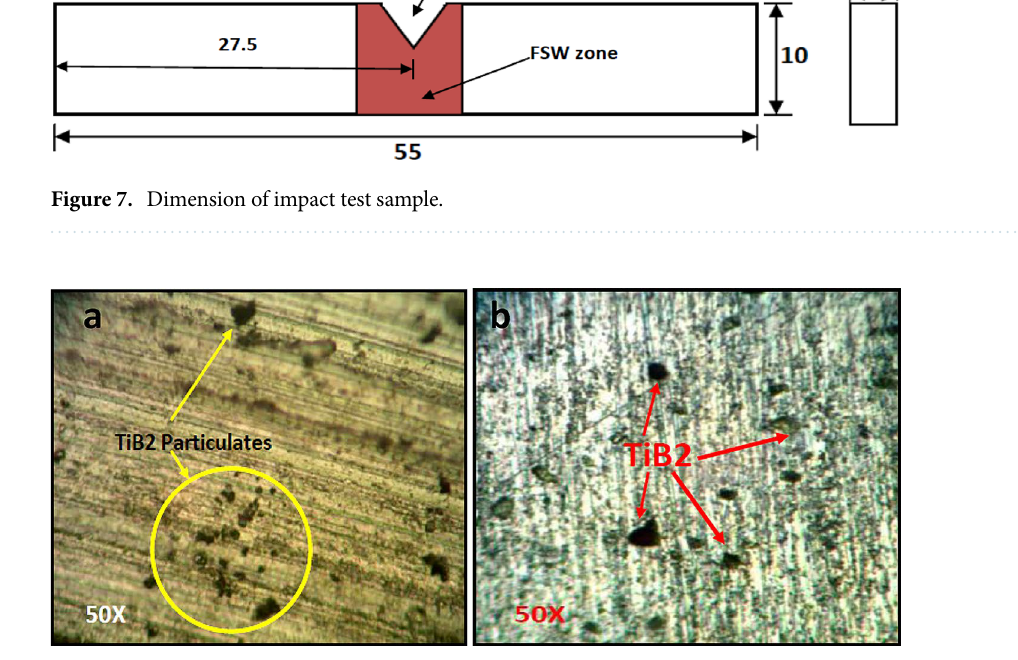
Figure 8. Optical micrograph of friction stir weld zone fabricated at ( a ) 2240 and ( b ) 1400